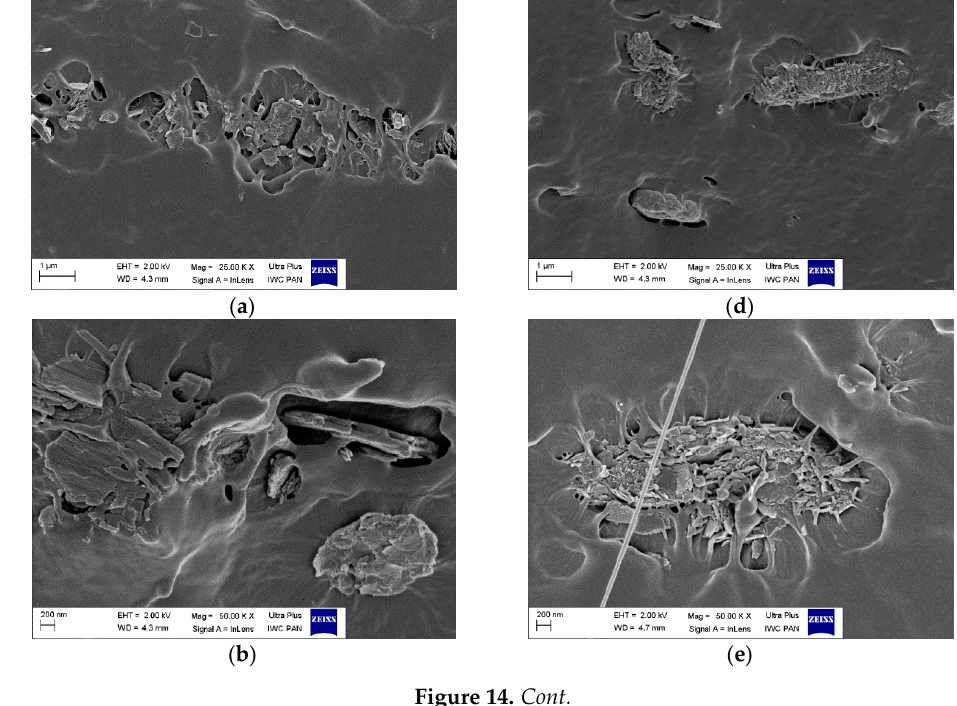
( f ) Figure 14. Scanning electron micrographs of ( a,b,c ) NBR and ( d,e,f ) EPM composites filled with 10 phr of hybrid pigment at different magnifications. 3.7. Barrier Properties Generally, the presence of layered minerals can improve the gas barrier properties of elastomer composites due to the formation of paths hindering the diffusion of gas molecules within the polymer matrix. Therefore, we assumed that the hybrid pigments based on layered double hydroxides would strongly affect the air permeability of NBR and EPM composites. The gas transmission rate (GTR) and gas permeability coefficient (P) parameters were determined using the manometric method. The results are listed in Table 5.